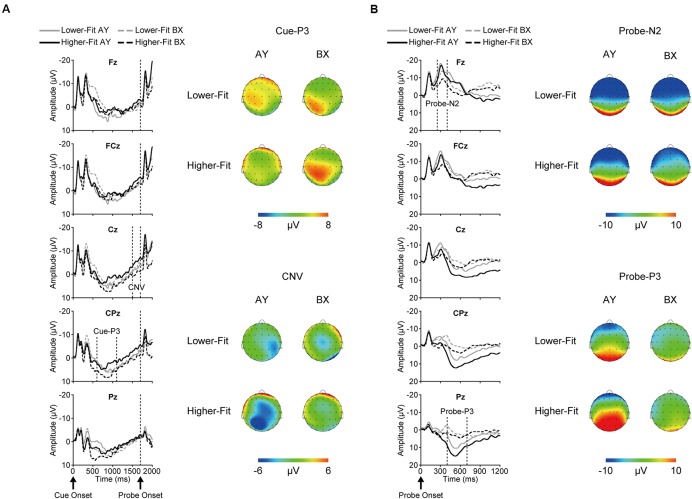
Grand average event-related brain potential (ERP) waveforms and topographical maps for each ERP component after cue onset (A) and probe onset (B) for each group and trial type.